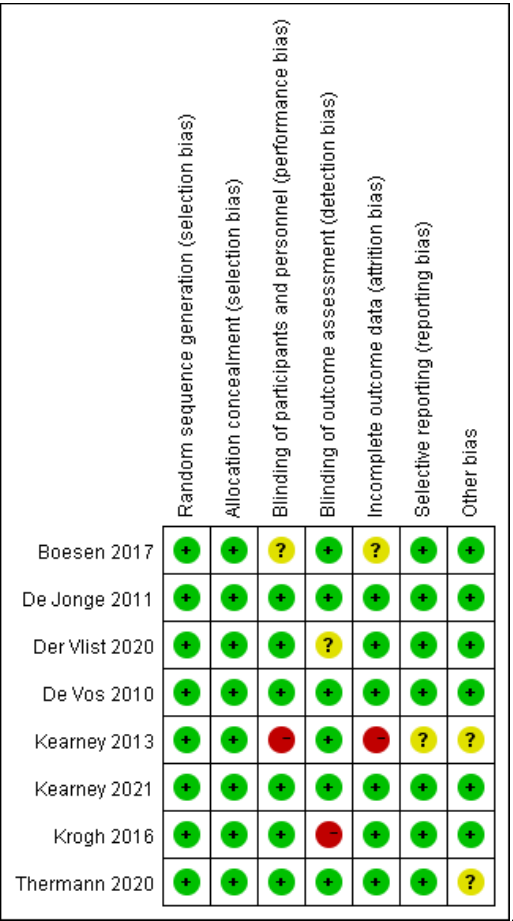
Figure 2. Proportional risk of bias graph: judgement of the percentage of bias items arising from all included studies.